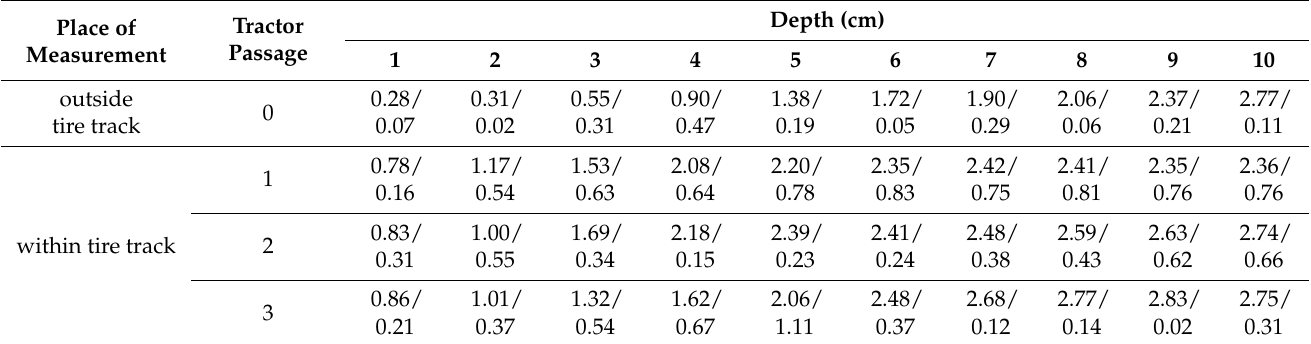
Table 1. Penetrometer resistances (mean/standard deviation, MPa).